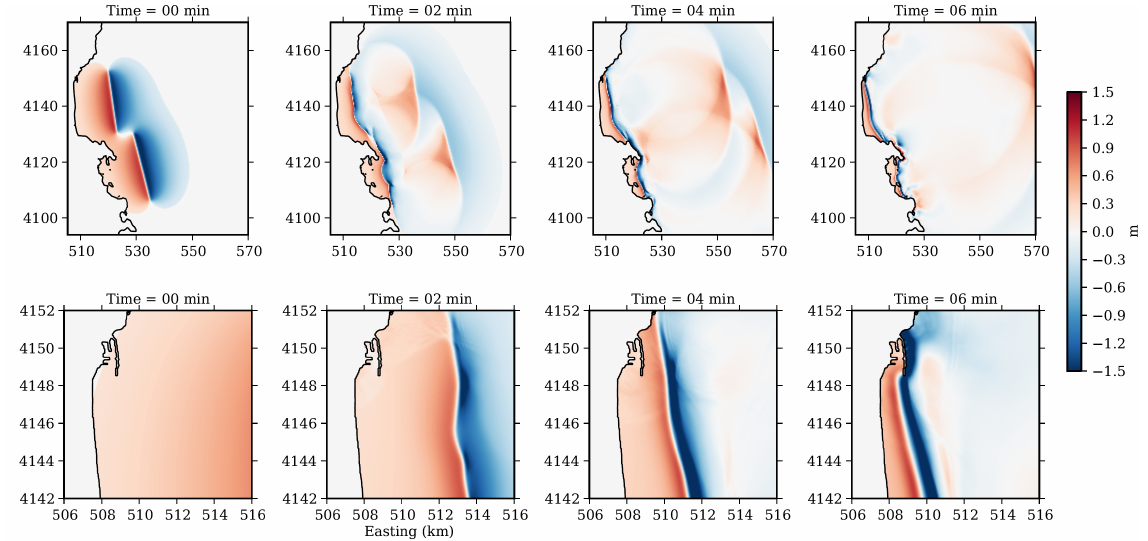
Fig. 21. Sea surface elevation. Tsunami initial condition and propagation fields computed after 2, 4 and 6min are shown for the entire (65km × 75km) grid (upper row) and for the area of Catania and of the beach La Plaia (lower